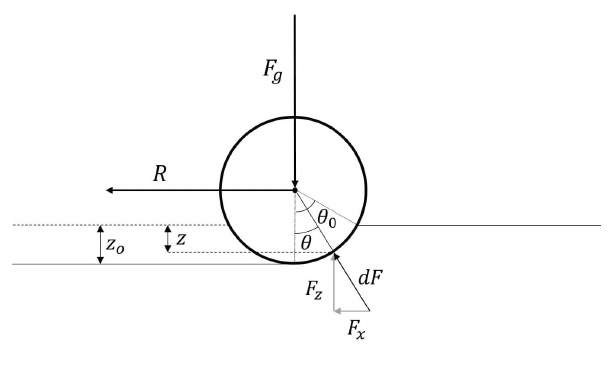
Figure 1. Schematic of a wheel compressing snow as it drives over a smooth surface. F g is the overburden force due to gravity acting on the chassis and rover wheel, R is the resistance force felt from compaction and internal friction, z 0 is the depth the rover sinks into the ground, and θ 0 and θ are the angles which become important for integrating the traction around